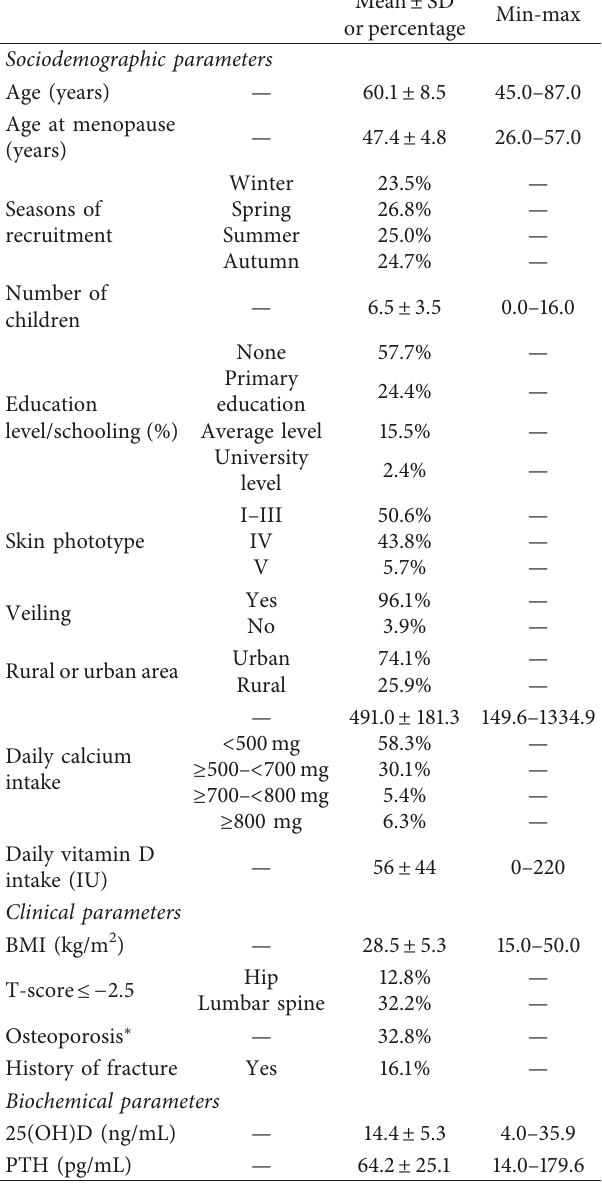
Table 1: Sociodemographic, biochemical, and clinical character- istics of the study population ( n �